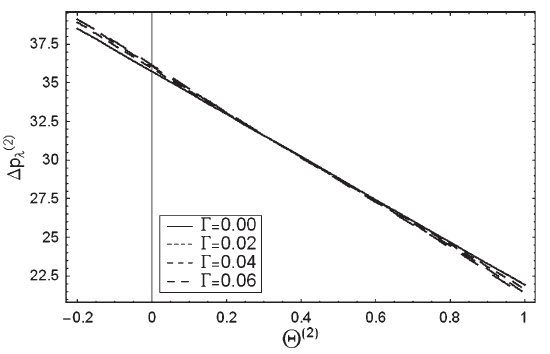
with θ (2) Fig. 5. Effect of Froud number Fr on variation of (cid:16)p (2) λ a = 0 . 3, b = 0 . 5, d = 0 . 7,Re = 10, (cid:15) = 0 . 04, β = 0 . 1,sin α = 0 . 6 and φ = π/